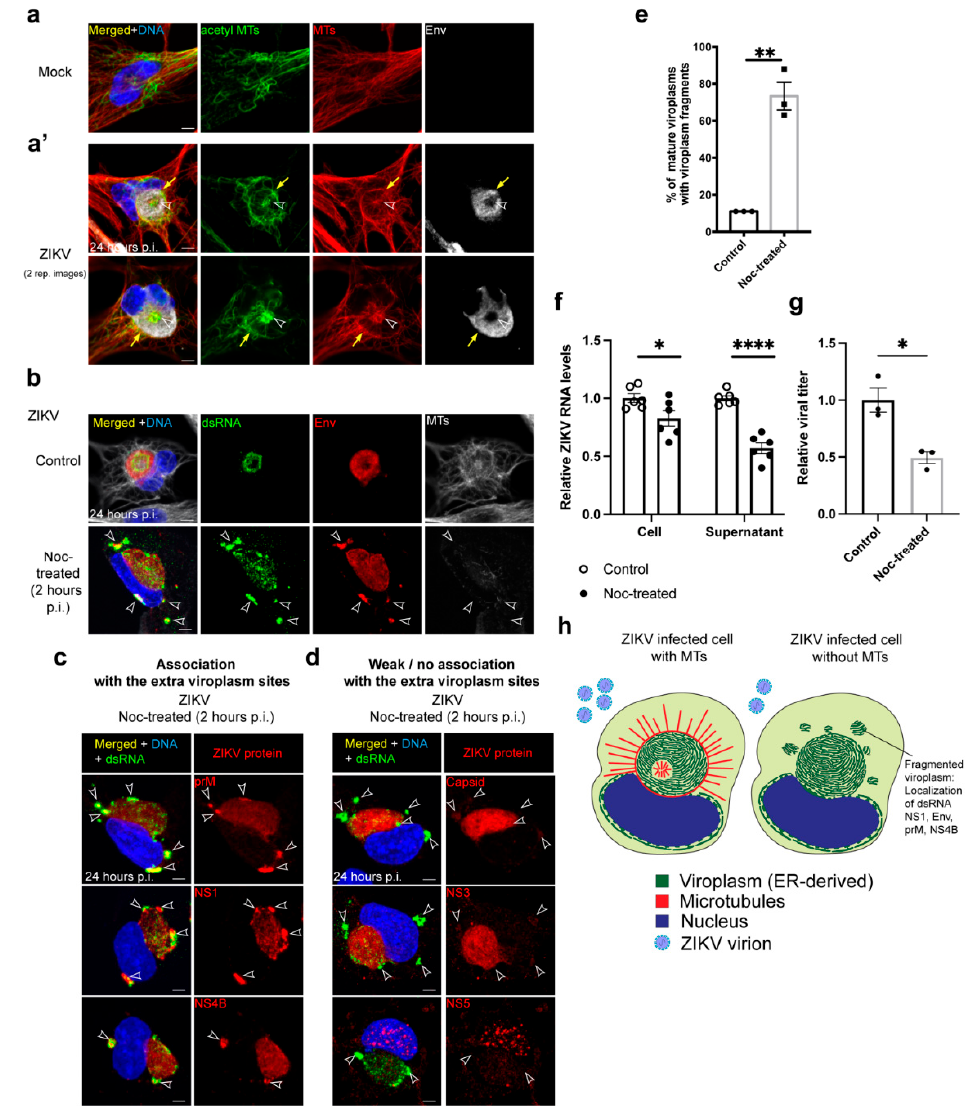
Figure 2. MTs are required for ZIKV viroplasm organization and efficient virus production ( a , a’ ): IF staining of relatively stabilized acetylated (acetyl) MTs (green) and dynamic tyrosinated MTs (labeled MTs, red) of mock- and ZIKV-infected (MR766) SNB19 cells 24 h p.i. Viroplasms are marked with Env (white). Two representative images are shown for the MT cluster (indicated by arrowheads) at the core of the viroplasm. Arrows indicate MTs surrounding the viroplasm; ( b ) IF staining of control and nocodazole (noc)-treated cells 24 h p.i. dsRNA (green) and Env (red) marks ZIKV infected cells. Noc was added to cells 2 h p.i and remained in culture until fixation, and the MT array (white) is disrupted. White arrowheads point to extra viroplasm sites; ( c , d ) representative IF images to assess the localization of ZIKV proteins (red) to viroplasms contained for dsRNA (green) in noc-treated (2 h p.i.) ZIKV infected cells 24 h p.i. From two independent experiments (n = 18–31 imaged cells), ( c ) shows the ZIKV proteins that localize to the extra sites, and ( d ) shows the ZIKV proteins that are weakly or are not found at the satellite structures. They mostly localize to the mature main viroplasm (capsid, NS3) or the nucleus (NS5); ( e ) quantification of control and noc-treated ZIKV infected cells with mature viroplasms with viroplasm fragments as marked by dsRNA. T -test comparing the frequency of viroplasm fragments for the following conditions from three independent experiments (18–27 infected cells/experiment), infected: control vs. noc-treated ( p -value < 0.01, **); ( f ) quantification of normalized ZIKV genome RNA levels in cell pellets and supernatants (medium) of S-phase arrested control and noc-treated (2 h p.i.) ZIKV-infected cells. RNA levels were measured by Reverse Transcription-quantitative PCR (RT-qPCR). T-tests comparing the viral RNA levels for the following conditions from six independent experiments, infected cell pellet: control vs. noc-treated ( p -value = 0.043, *), infected supernatant: control vs. noc-treated ( p -value < 0.0001,